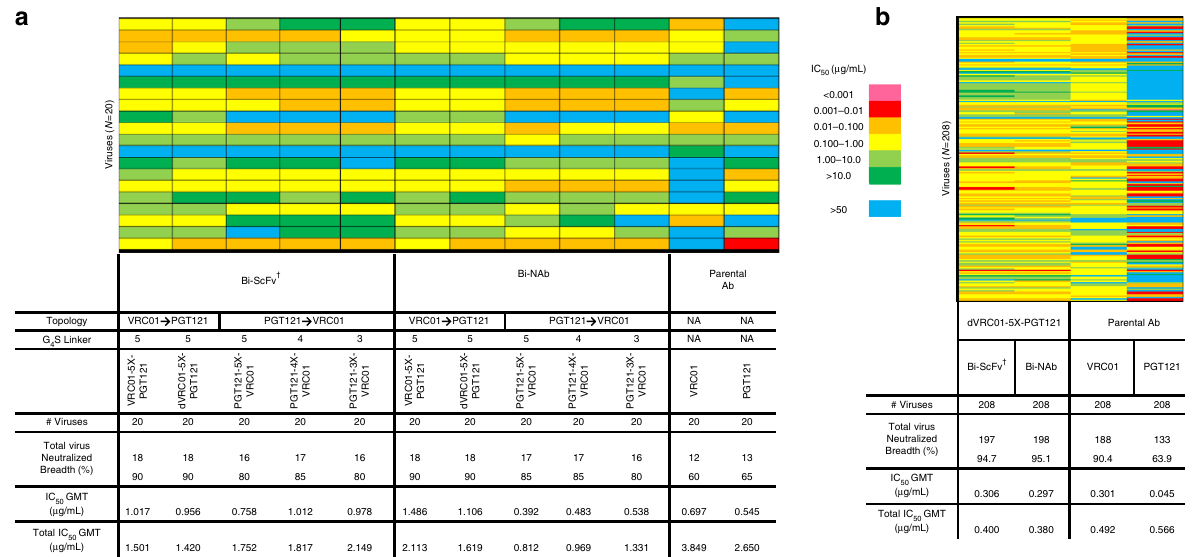
Fig. 4 Neutralization breadth and potency of bispeci fi c antibodies. a Neutralization breadth of the parental and bispeci fi c antibodies was tested against an HIV-1 pseudovirus panel consisting of Envs of 20 viral strains. Heat maps of IC 50 titers were generated in Excel. In the heatmaps, each row represents a virus strain while columns represent antibodies. Warmer colors indicate more potent neutralization and blue indicates at 50 µ g/mL, antibody virus neutralization is below detection threshold (see legend). Breadths based on IC 50 s are also summarized. Potencies (IC 50 geometric mean values, GMT) were calculated against sensitive viruses. Total IC 50 GMT value, is also shown when IC 50 titers for all tested virus were included and an IC 50 value of 50 µ g/mL was assigned to a neutralization-resistant virus ( † indicates that the IC 50 was adjusted by a factor of 3 to account for the molarity difference between the lower molecular weight Bi-ScFv and the IgG or Bi-NAb). b Neutralization breadth of the parental and bispeci fi c antibodies was tested against a panel of 208 viral strains. Heat maps of IC 50 , breadth and potency are shown as in the Bi-ScFv dVRC01-5X-PGT121 and Bi-NAb dVRC01-5X-PGT121 dis- played improved coverage with 94.7 and 95.1% of viruses neutralized, respectively, over the parental antibodies (VRC01 = 90.4%, and PGT121 = 64%; Figs. 4b and 5a) and with an